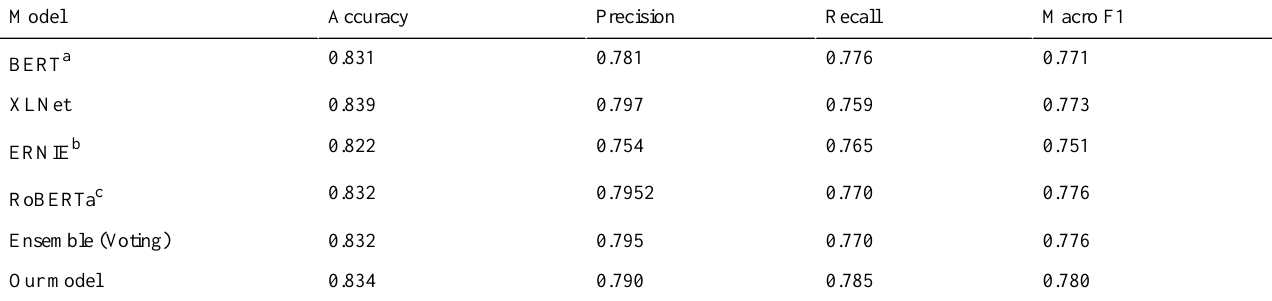
Table 3. The performance of the 6 models using the reduced training data